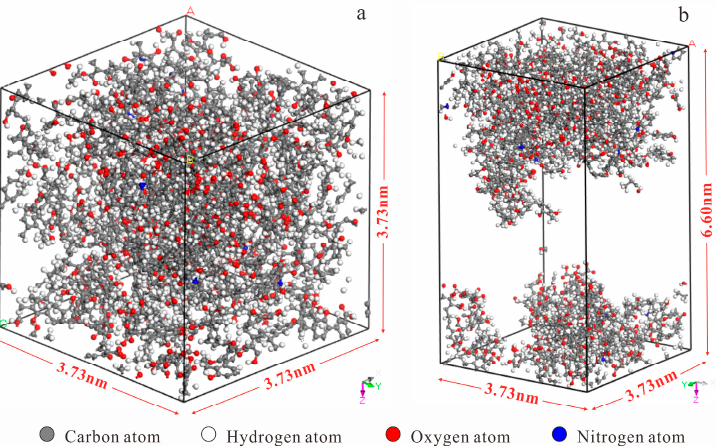
Figure 6. ( a ) Three-dimensional molecular structure model of the FK–3 coal.; ( b ) The 3D molecular structure model added with 1 nm blank slit blank